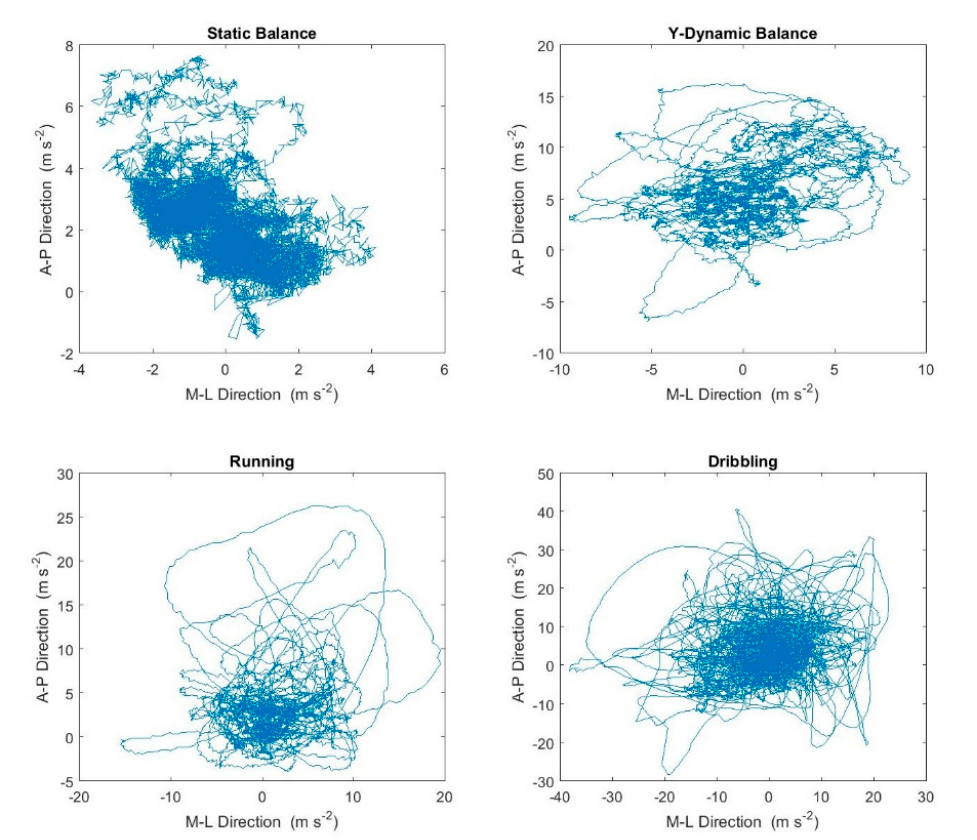
Figure 1. Acceleration of body center in Mediolateral (M-L) and Anteroposterior (A-P) directions during four selected